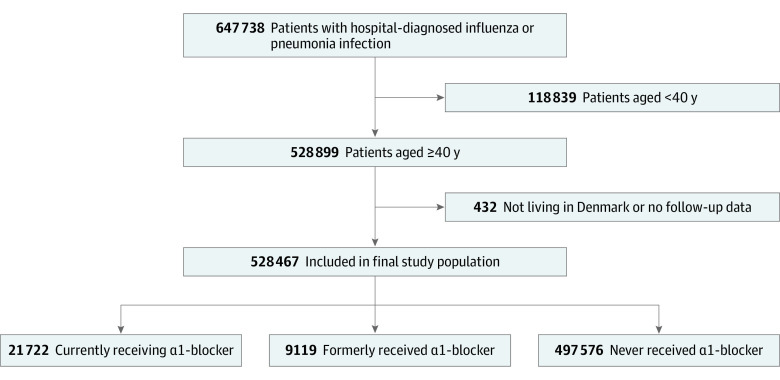
Patient Flow Diagramα1-blocker indicates α1–adrenergic receptor blocking agent.